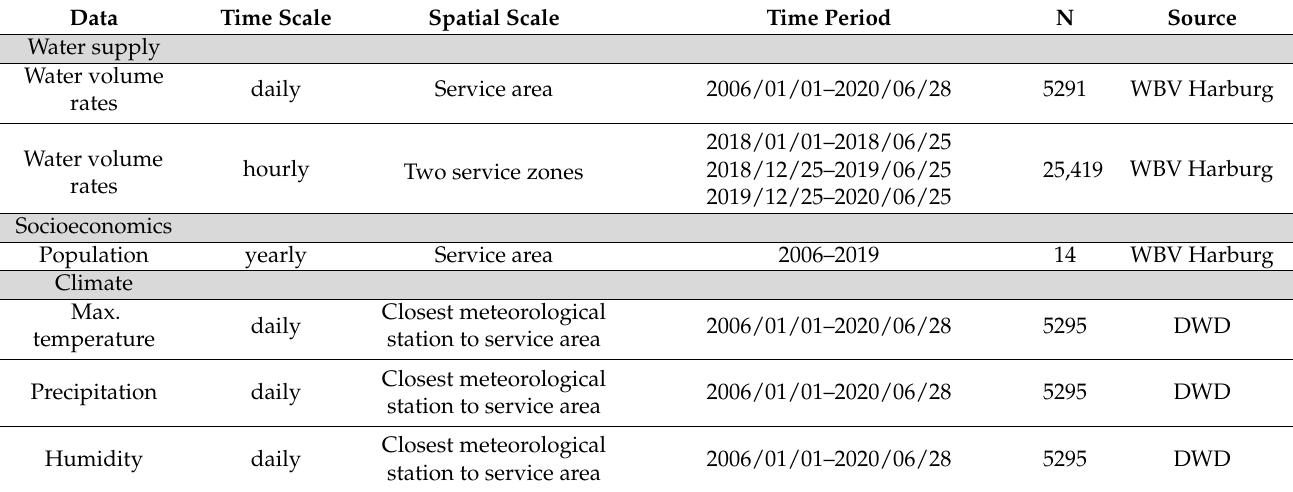
Table 1. Overview of the available data. We removed two outliers of the daily water volume